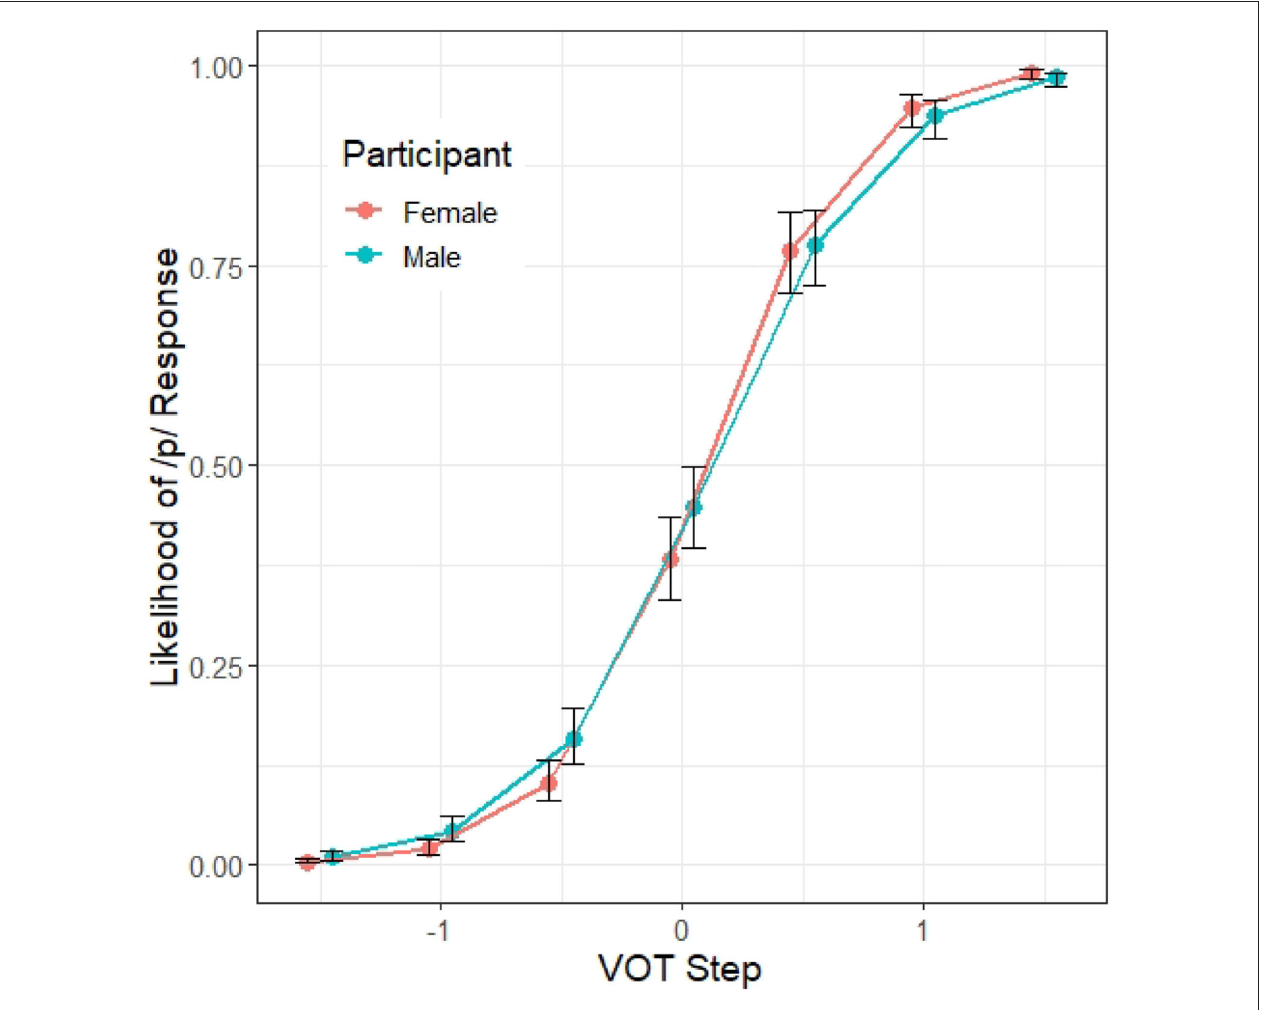
FIGURE 4 | Model 1 predictions of the probability of a /p/ response (y axis) at different steps along the VOT continuum (x axis) by the gender of the participants. The error bars indicate 95% confidence